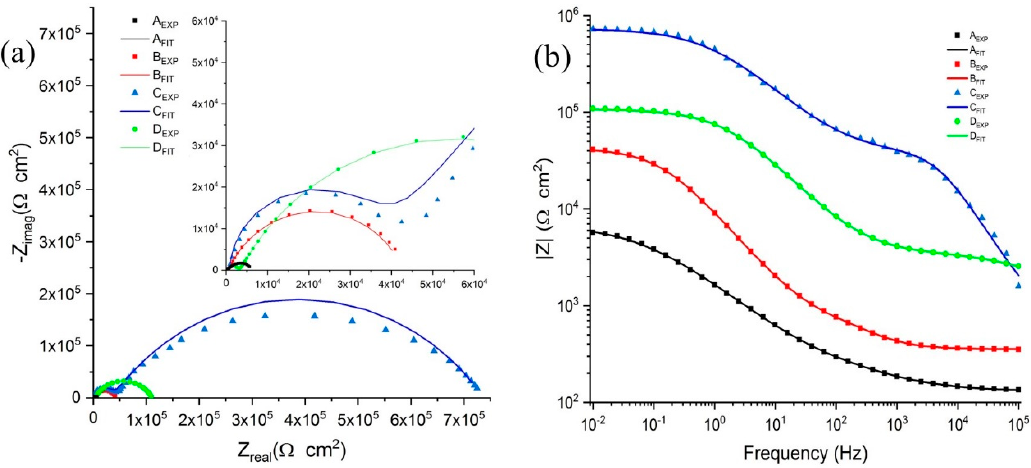
Figure 8. ( a ) Nyquist and ( b ) bode diagrams of the scratched samples immersed in the NaCl solution for 8 days.